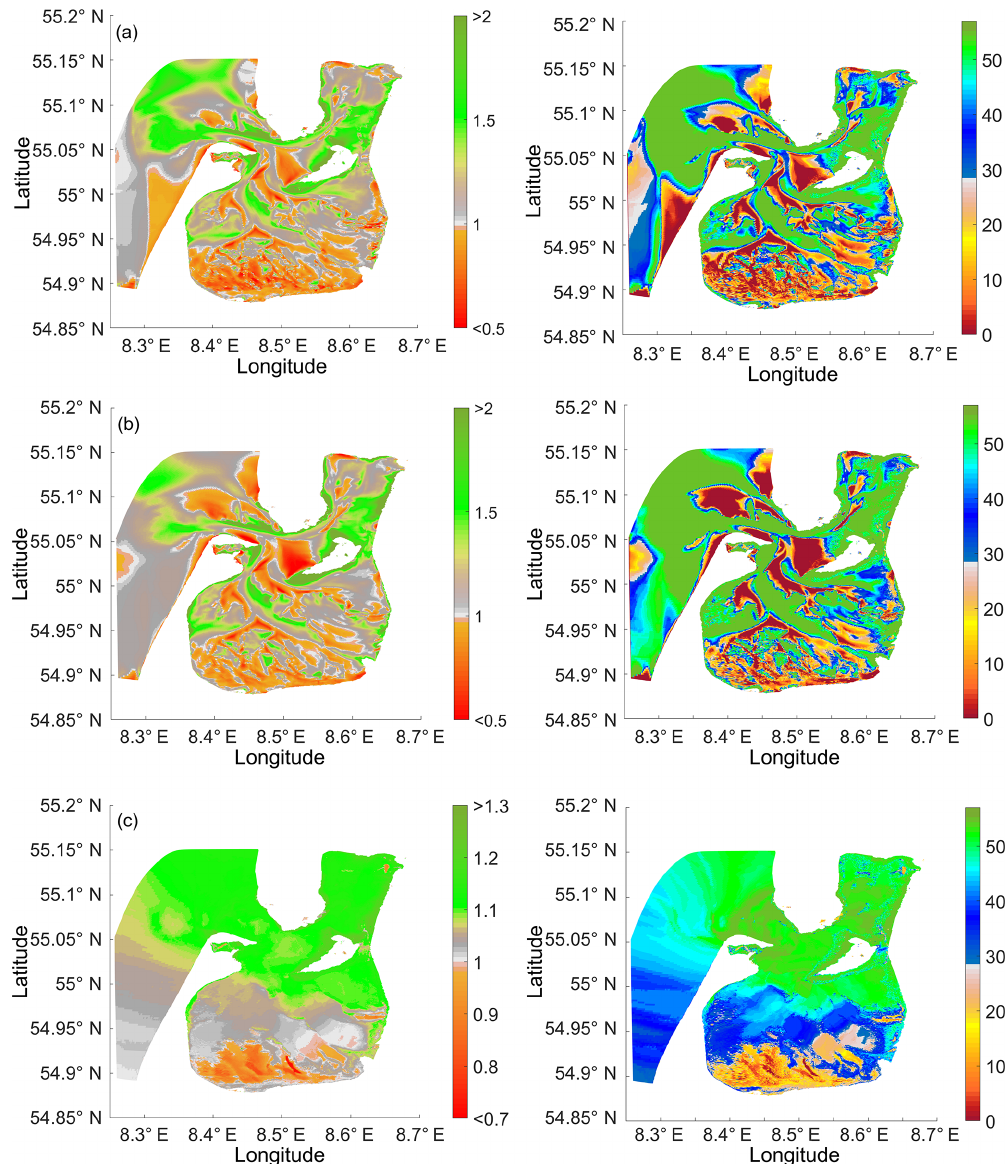
Figure 9. The ebb-flood dominance asymmetry maps. Left panels: ratio of (a) maximum velocities during ebb and flood, (b) mean velocities during ebb and flood, and (c) durations of flood and ebb. Right panels: frequency of event within a lunar (synodic) month (amount of the tidal cycles) (a) maximum velocities during ebb are higher than during flood, (b) mean velocities during ebb are higher than during flood, and (c) flood is longer than ebb. Numbers 1–4 indicate different zones under consideration. The A, B demonstrates an example of the subareas in which the strong flood dominance in terms of velocity does not mean shorter flood. Subareas which do not take part in at least one flood–ebb cycle are